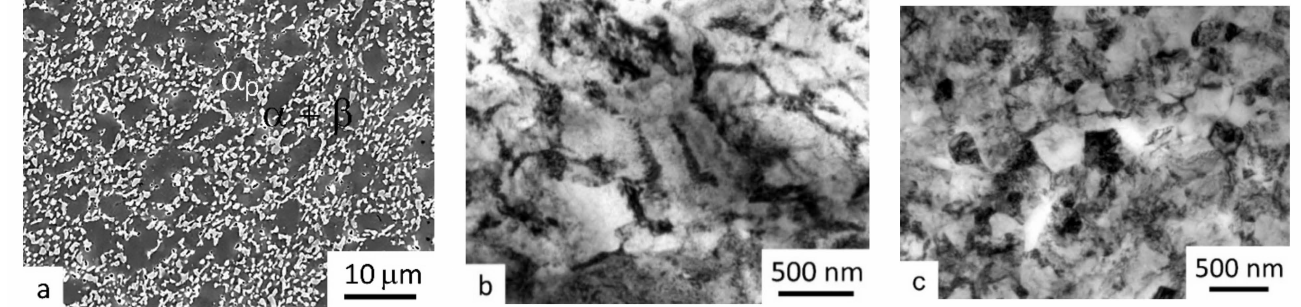
Figure 3. Microstructure images for the Ti-6Al-4V alloy samples after the standard HT and ECAP: ( a ) general view of the structure in a SEM image, ( b ) TEM image of the primary α -phase; ( c ) TEM image ( α + β ) of the UFG